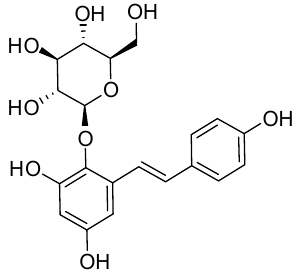
Figure 1. Chemical structure of 2,3,5,4 ′ -Tetrahydroxy-stilbene-2- O - β - D -glucoside (THSG).